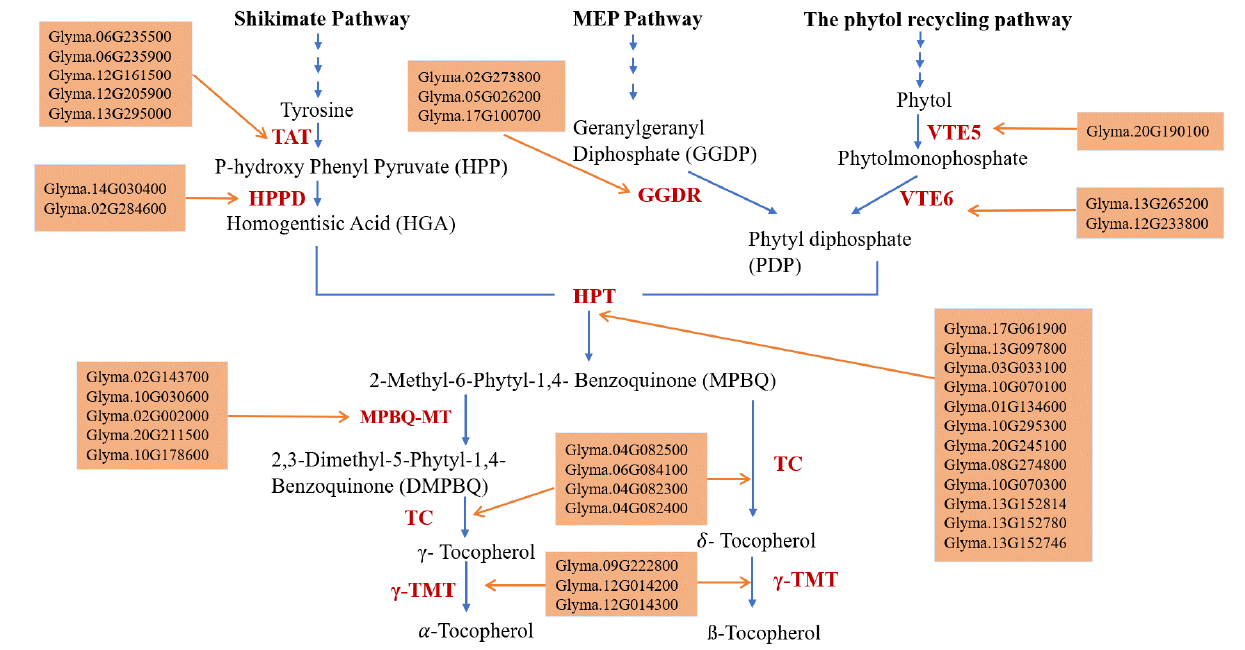
Figure 2. Tocopherol metabolic pathway [15] with identified candidate genes in soybean. TAT: Tyrosine Aminotransferase; HPPD: Hydroxyphenylpyruvate Dioxygenase; GGDR: Geranylgeranyl Diphosphate Reductase; HPT: Homogentisate Phytyl Transferase; MPBQ-MT: methylphytylbenzo- quinol methyltransferase; TC: tocopherol cyclase; γ -TMT: gamma tocopherol methyltransferase. MEP Pathway: methylerythritol 4-phosphate pathway.